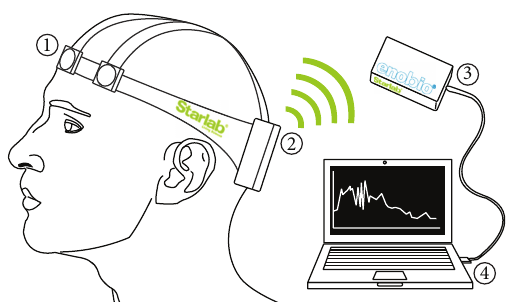
Figure 1: System overview.